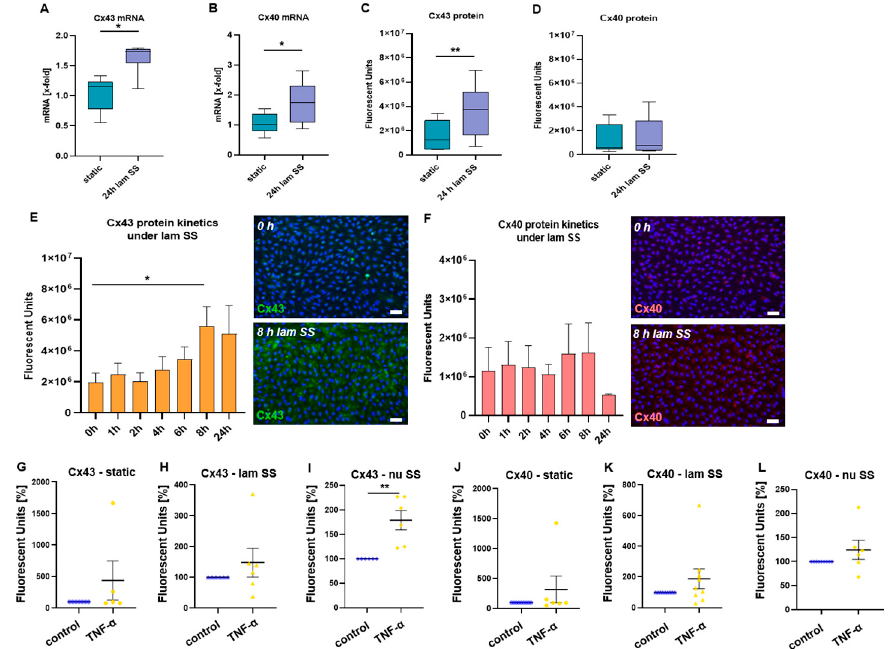
Figure 3. Mechanic and inflammatory induction of Cx expression in HUVECs. HUVECs were seeded into laminar ( A – D ) or bifurcation flow-through cell culture slides ( E , F ) and exposed to SS by application of flow for 0–24 h. ( A , B ) RNA was isolated from HUVECs following 24 h flow or static conditions for RT-qPCR, showing higher transcription levels of both Cx43 ( A ) and Cx40 ( B ) following laminar SS compared with static conditions ( n = 6). ( C , D ) After 24 h of flow or static conditions, HUVECs were stained for Cx43 and Cx40 by immunofluorescence ( n = 9). Cx43 expression was significantly higher under laminar SS compared with static conditions ( C ), while no significant changes were observed for Cx40 ( D ). Data are presented using box and whisker plot, showing median, the interquartile range and minimum and maximum values. Wilcoxon matched-pairs signed rank test ( A , D ) or paired t test ( B , C ) was used for analysis. ( E , F ) At different time points (0 h, 1 h, 2 h, 4 h, 6 h, 8 h and 24 h of flow) HUVECs were stained for Cx43 and Cx40 by immunofluorescence ( n = 3–4). After 8 h exposure to laminar SS significantly higher expression levels of Cx43 were observed compared with 0 h ( E ), while no significant differences were observed for Cx40 ( F ). Data are presented as mean ± SEM. Unpaired t-test was used to analyze the different time points compared with 0 h. Exemplary microscopic images of immunofluorescent stained HUVECs are shown on the right (Cx43 = green, Cx40 = red, DAPI = blue, scale bar = 100 µm). ( G – L ) Impact of inflammatory stimulation on Cx expression in HUVECs exposed to static or flow conditions was analyzed by immunofluorescent stainings. Stimulation with TNF- α for 2 h had no effect on Cx43 and Cx40 expression under static conditions ( G , J ) or under laminar SS conditions ( H , K ). HUVECs exposed to non-uniform SS exerted higher Cx43 expression following TNF- α stimulation ( I ), while Cx40 expression levels were unchanged ( L ). Data are presented as mean ± SEM, dots represent values from individual experiments, n = 5–9, unpaired t -test was used for analysis. * p < 0.05, ** p < 0.01.